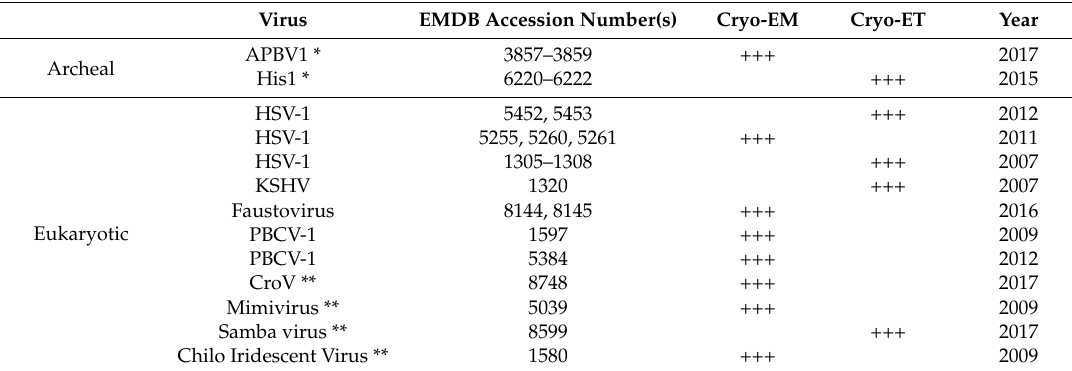
Table 3. Inventory of asymmetric cryo-EM/cryo-ET structures of eukaryotic and archeal viruses with DNA genomes that contain protein complexes that break icosahedral symmetry.